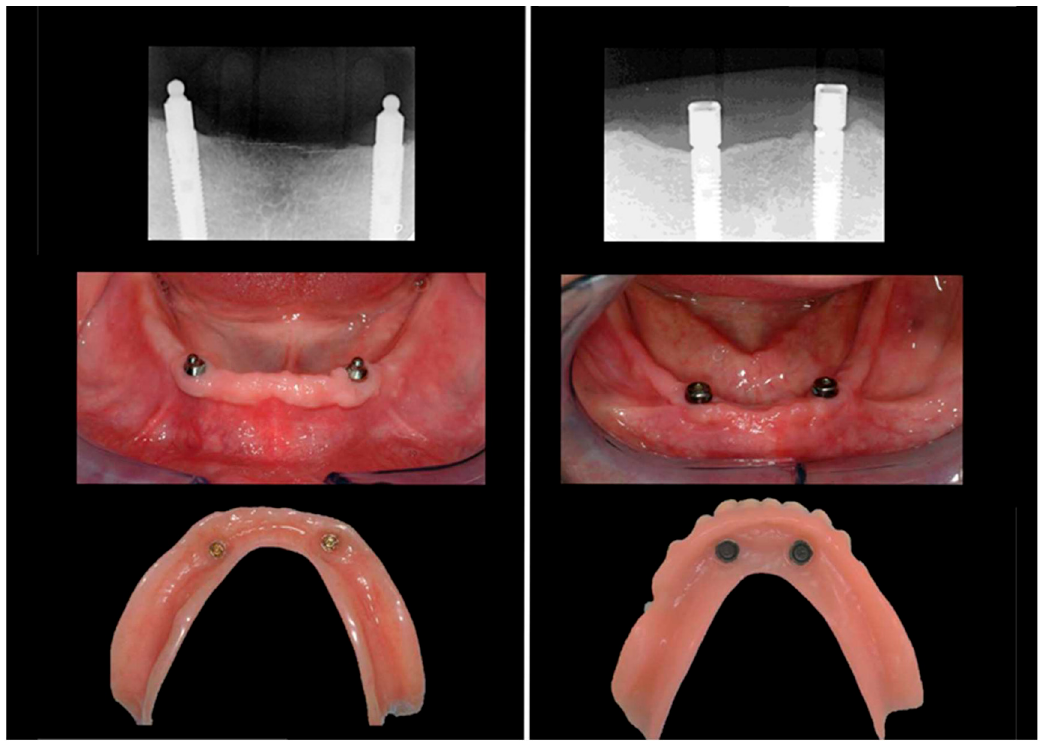
Figure 1. Radiographical and clinical example an overdenture retained on 2 non-connected implants on either 2 ball abutments (left) or 2 locator abutments (right).